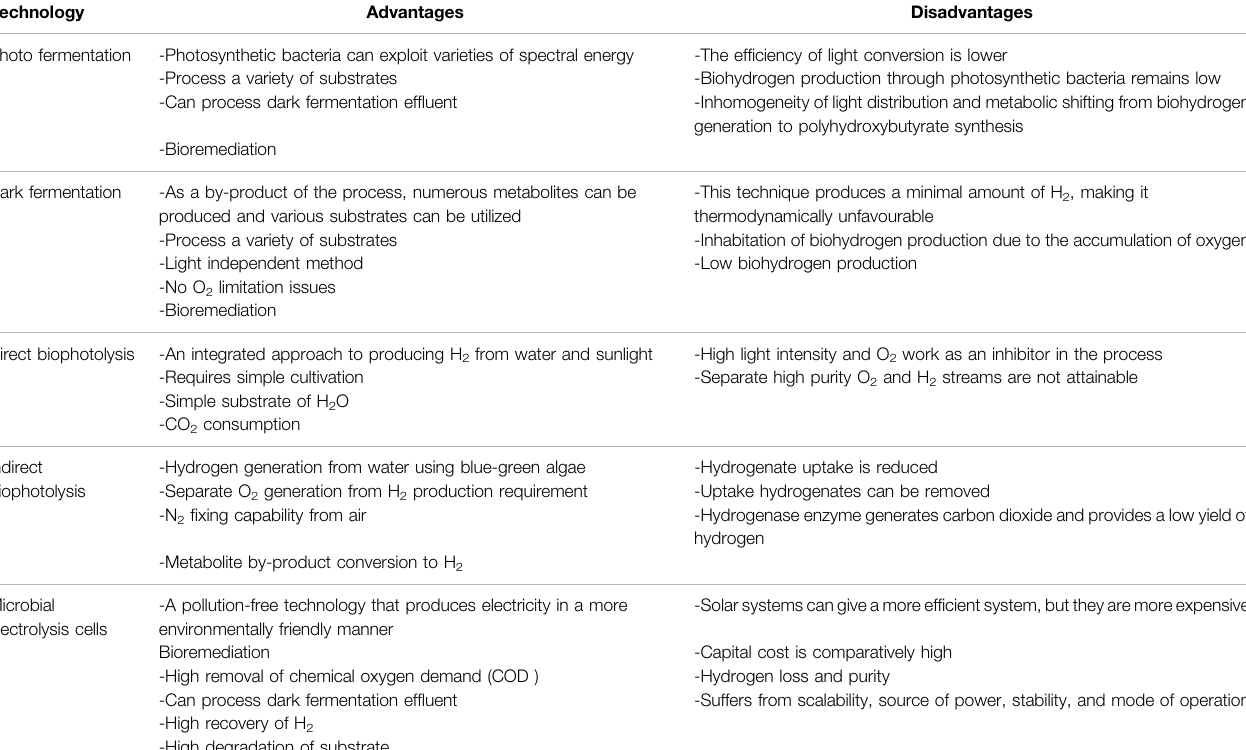
TABLE 1 | Advantages and disadvantages of basic biohydrogen production technologies.